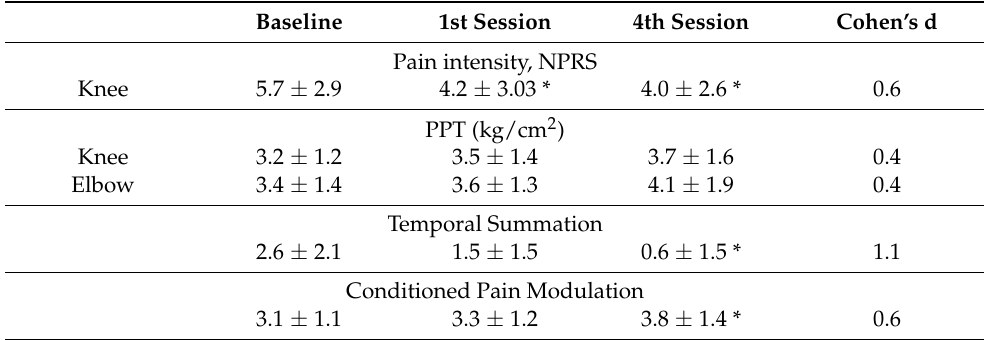
Table 2. Mean (SD) and mean difference within the group for numeric pain rating scale, temporal summation, pain modulation and pressure pain threshold at all study